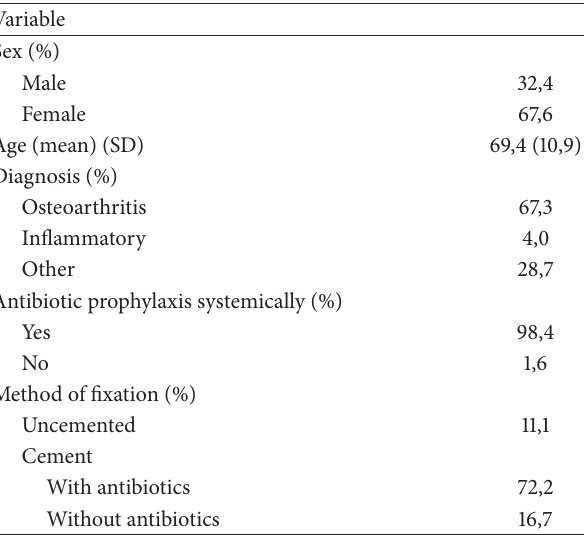
Table 1: Patient